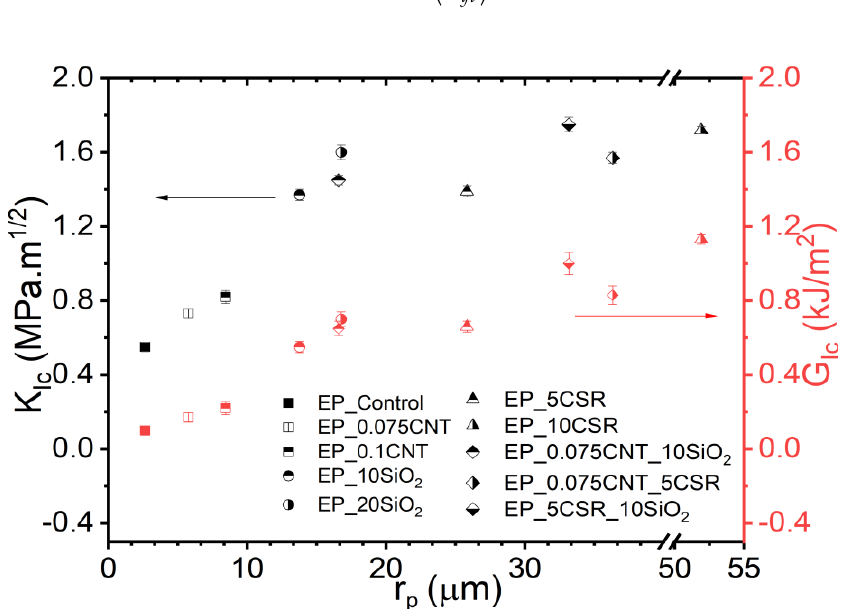
Figure 5. Fracture toughness and critical energy release rate of carbon nanotube (CNT), SiO 2 and core-shell rubber (CSR)-modified epoxy systems as a function of plastic zone radius r p .